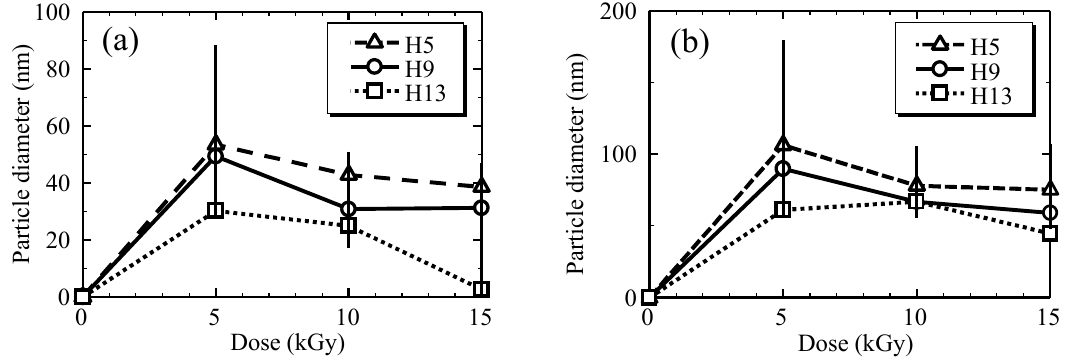
Figure 2. Average particle diameter of 0.1 wt.% HGHGH (H5—triangles, dashed line), HGGGHGGGH (H9—circles, solid line), and HGGGGGHGGGGGH (H13—squares, dotted line) aqueous solutions analyzed by number-weighted distribution ( a ), and intensity-weighted distribution ( b ) as a function of absorbed dose.